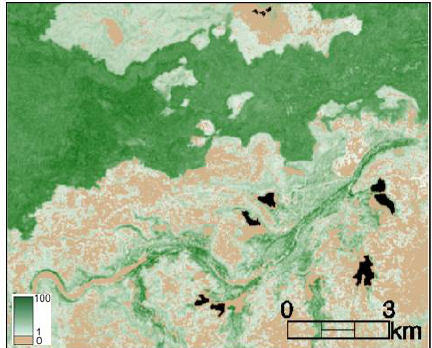
Figure 2. FPC as a measure of overstorey foliage cover in the study